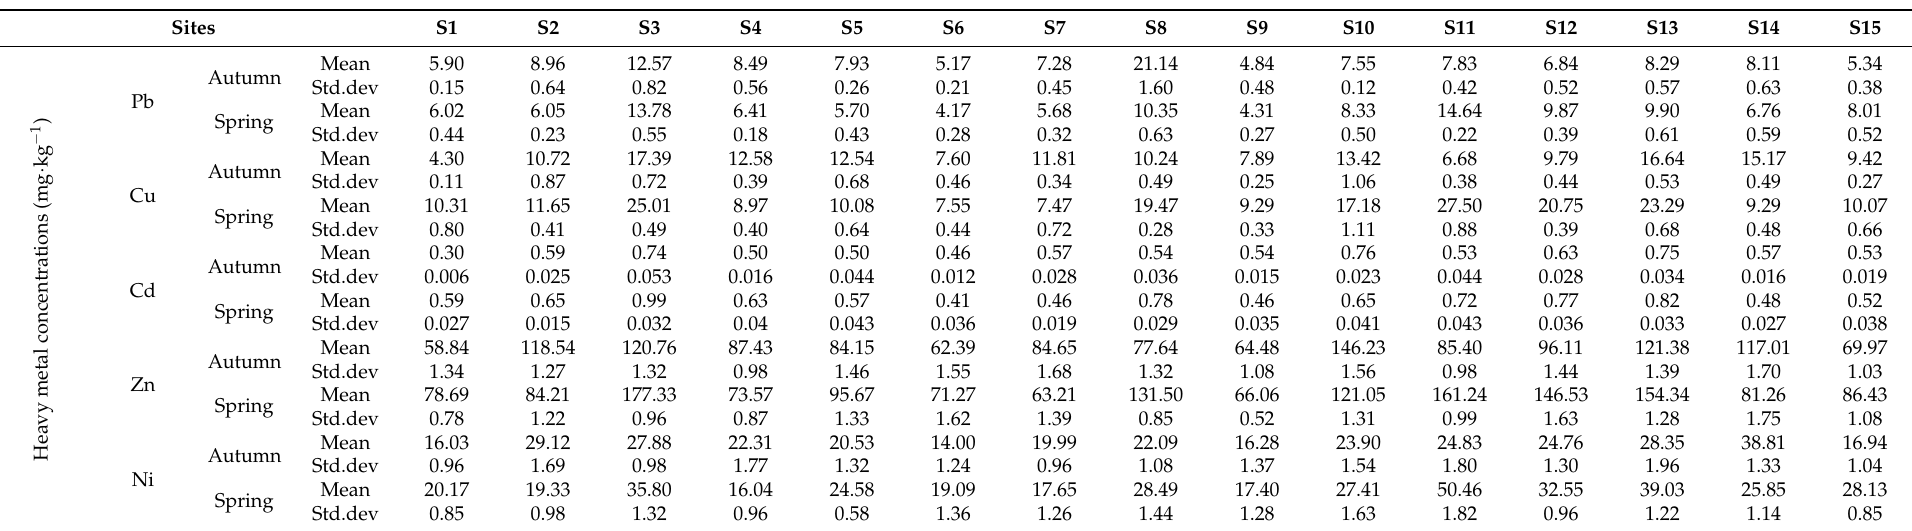
Table 6. Seasonal average of heavy metal concentrations and standard